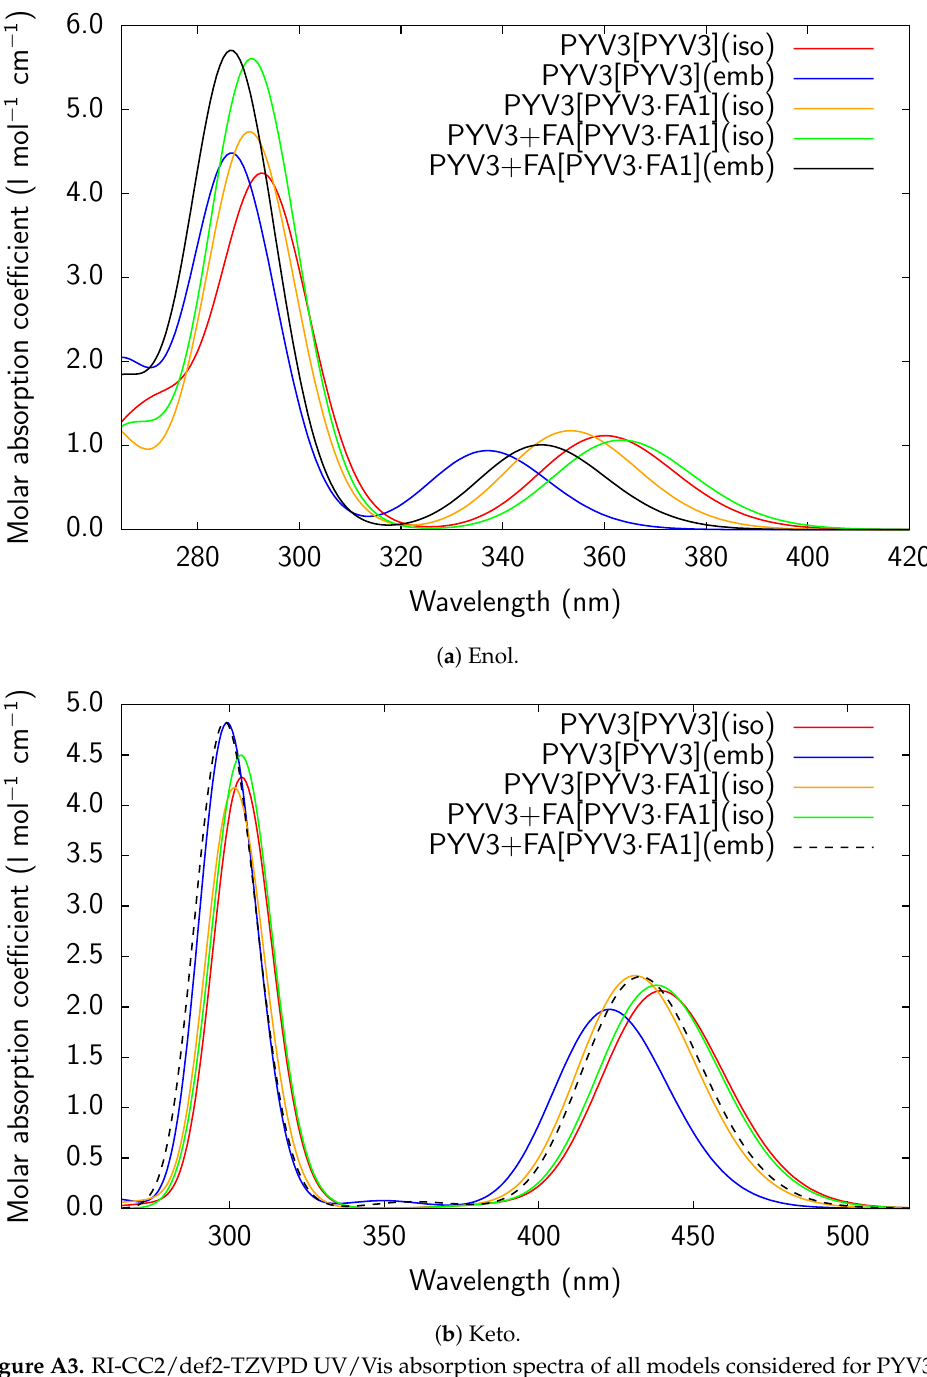
Figure A3. RI-CC2/def2-TZVPD UV/Vis absorption spectra of all models considered for PYV3 and PYV3 ·